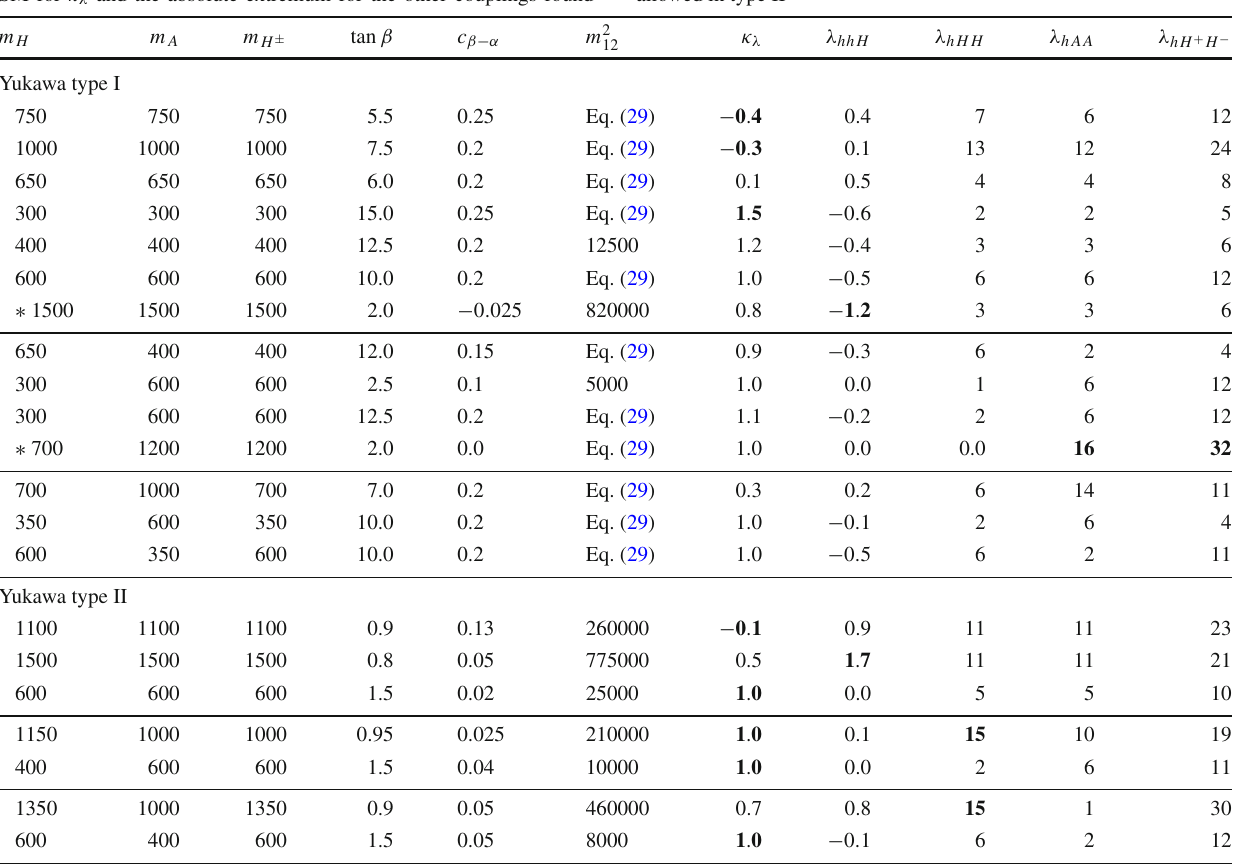
Table 3 Examples in the 2HDM for parameter inputs that present large size of some triple Higgs couplings allowed by current constraints in the Yukawa type I (top table) and Yukawa type II (bottom table). Values in bold are the ones that are close to the maximum deviation from the SM for κ λ and the absolute extremum for the other couplings found